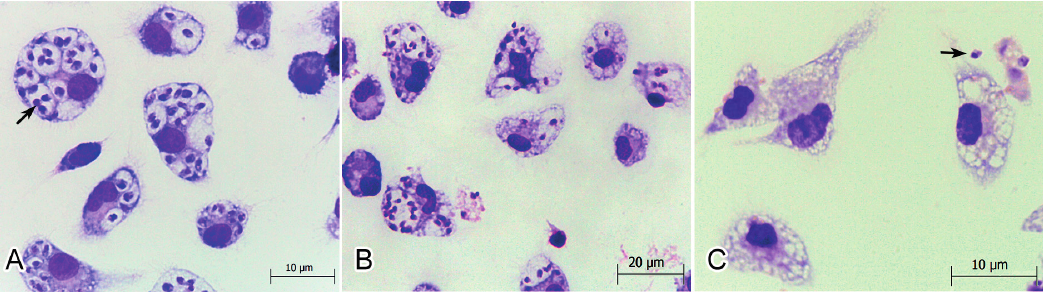
Figure 3. Light microscopy of the effects of DME on L. amazonensis -infected Balb/c peritoneal macrophages. ( A ) Giemsa-stained macrophages infected with amastigote (arrow); ( B ) Giemsa-stained macrophages infected with amastigotes and treated with the 72 µg/mL and ( C ) Giemsa-stained macrophage infected with amastigotes and treated with the 144 µg/mL DME. Note in (C) the absence of intracellular amastigotes.